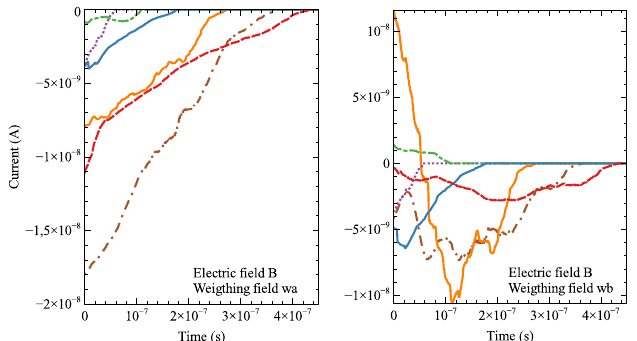
Fig. 18. Pulses simulated for the mpfd with the electrostatic potential B and the weighting fields wa (left) and wb (right). Pulses with the same line style correspond to the same fission track.